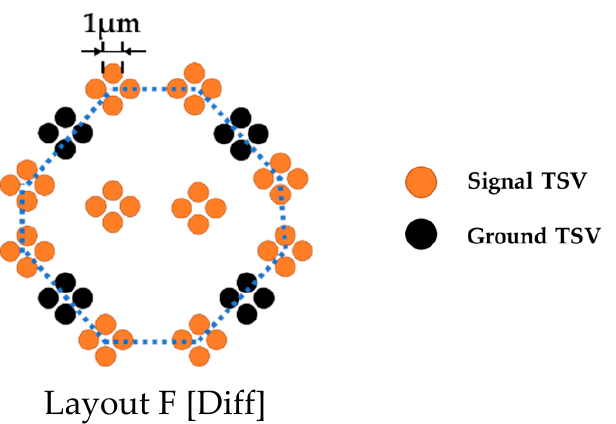
Figure 8. New division structure of octagonal TSV based on differential signals.